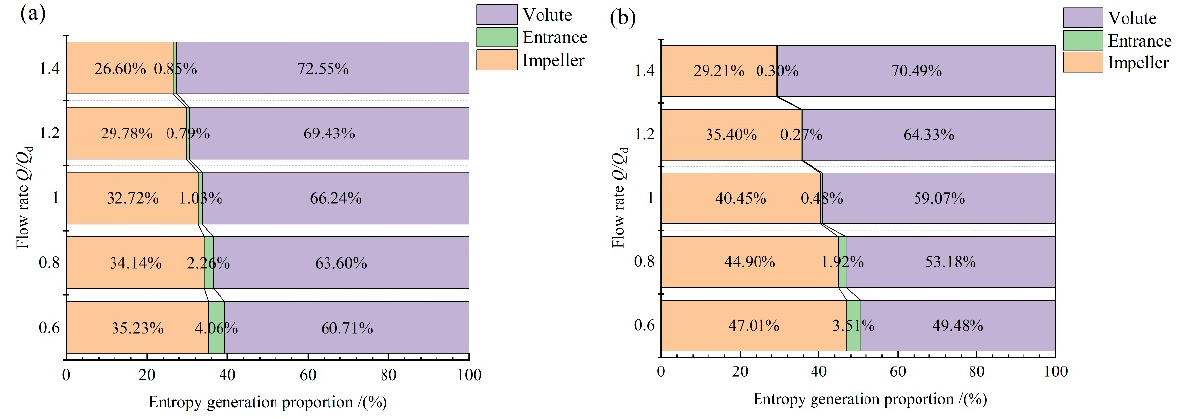
Figure 14. Proportion of entropy production of each flow passage component: ( a ) original scheme and ( b ) optimization scheme.